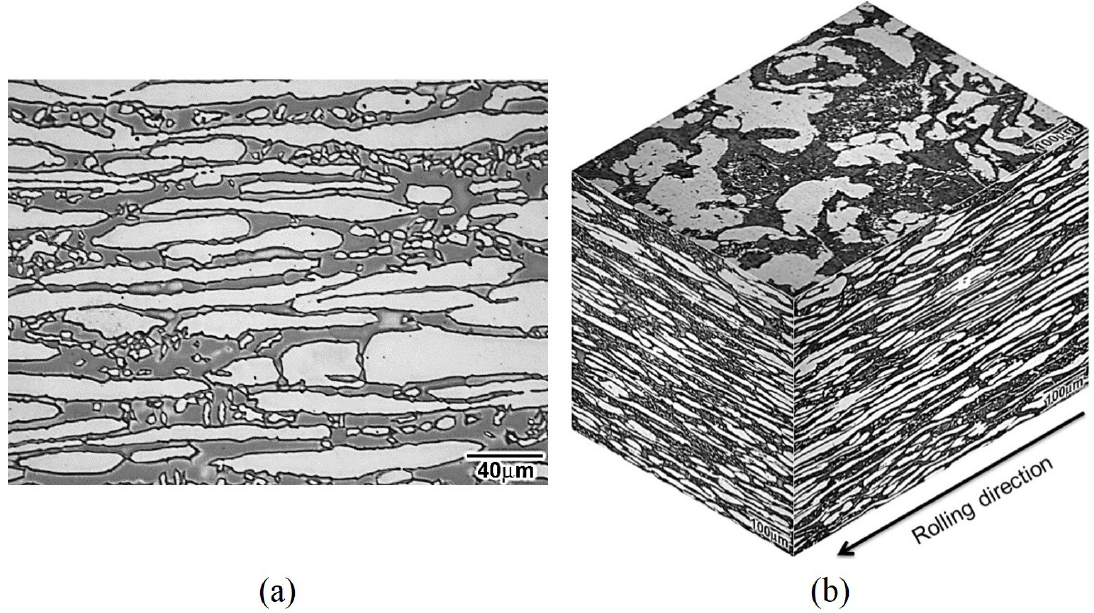
Figure 4. Cross-section microstructure of the UNS S32205 duplex stainless steel plate (a) and 3D assembly with the rolling direction (b) 20,21 . The microstructure comprises a ferritic matrix (α), dark phase, and elongated austenite (γ) precipitates, light phase. Ferrite content of 51%. OM, electrolytic attack in KOH